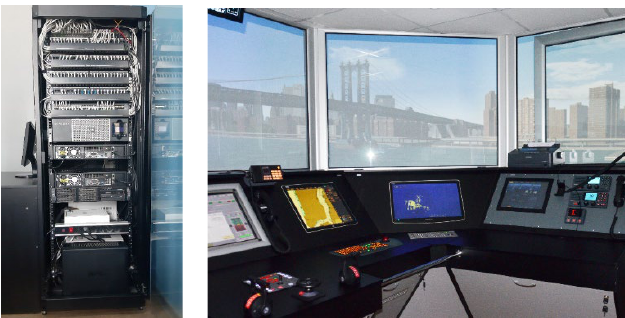
Fig. 2. Central rack of the simulator (left side) and a full mission navigational bridge (right